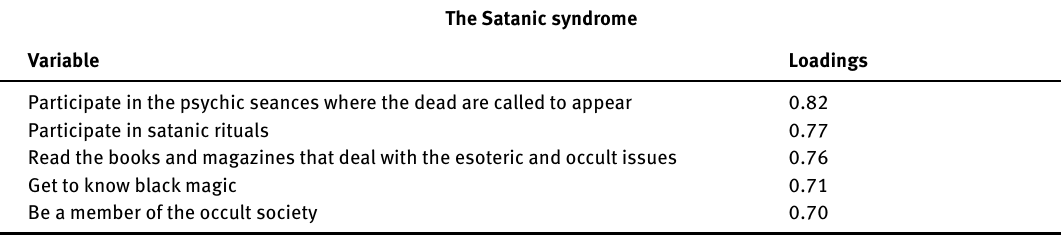
Table 2. Principal component of the Satanic